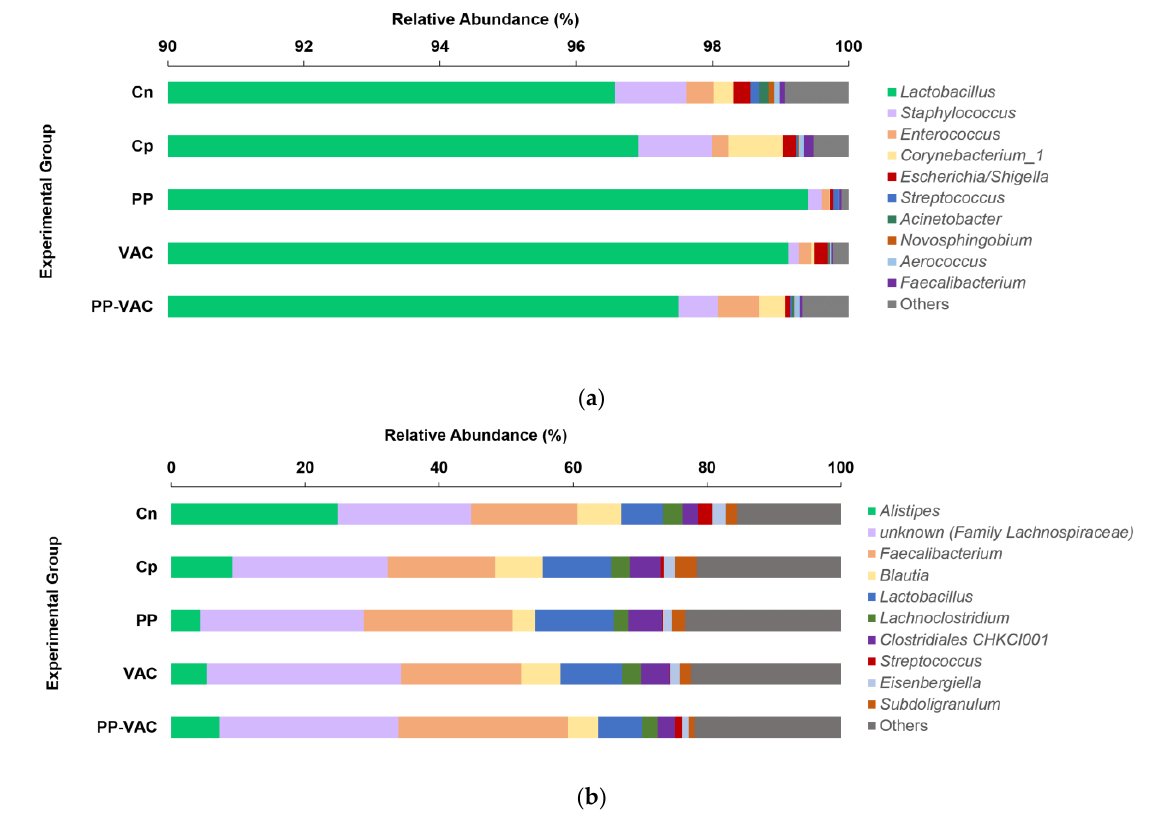
Figure 1. Stacked bar charts presenting the average relative abundances (n = 10/group) of main bac- terial genera in the ( a ) crop and ( b ) cecal digesta of 28-day-old Ross 308 broilers challenged with E. coli O1/O18 on day eight of life. Cn: Negative control, Cp: E. coli O1/O18 challenged control, PP: Pre-/probiotic addition, VAC: Parent stock vaccination, PP-VAC: Pre-/probiotic addition and parent stock vaccination.